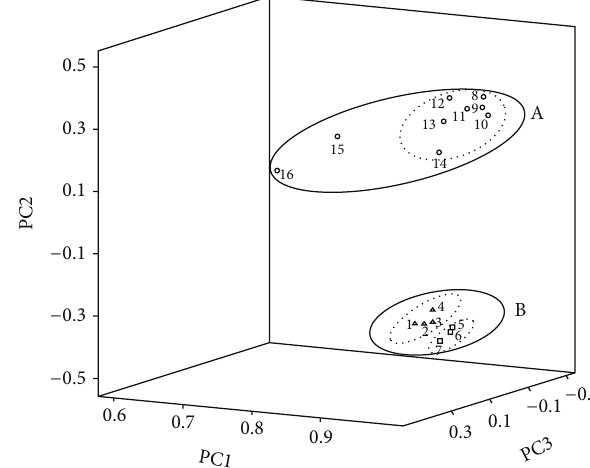
Figure 3: 3D plot of FTIR spectra of the 16 moss species based on PCA.